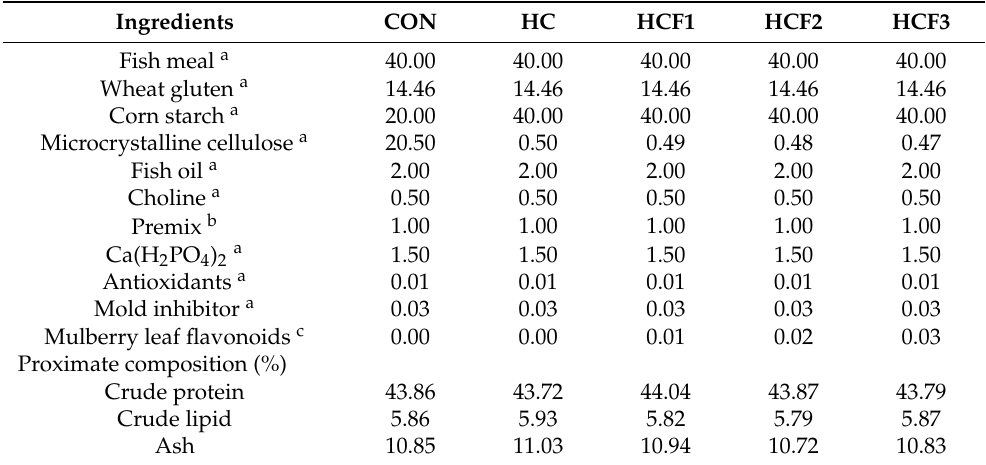
Table 1. Formulation and proximate composition of the experimental diets (%, dry